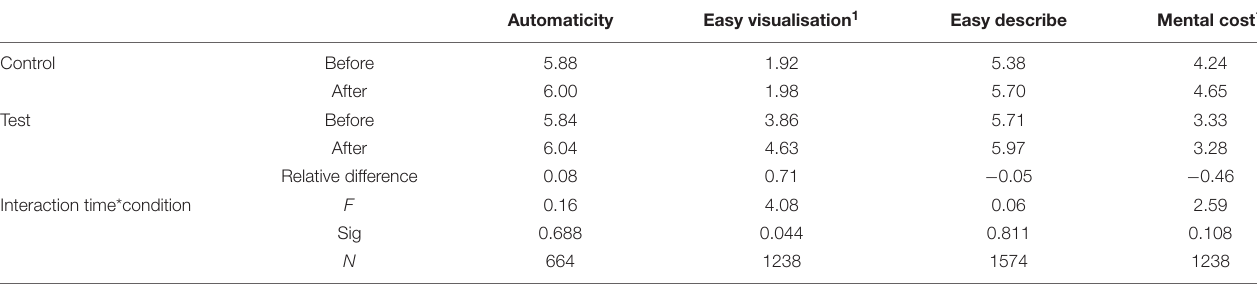
TABLE 5 | Perceptions about cycling in the street, before and after for test and control